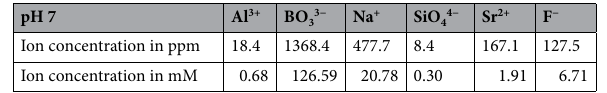
Table 1. Different ions concentration in the S-PRG